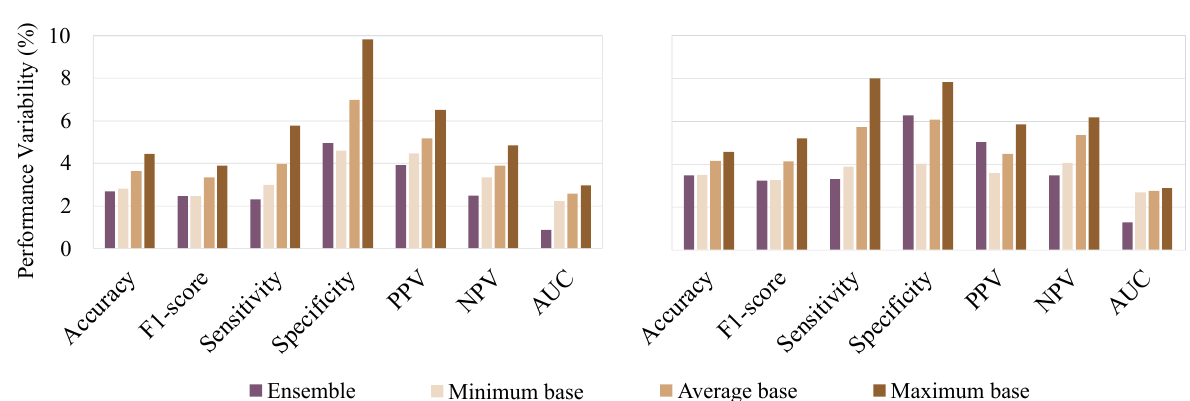
Figure 6. Base and ensemble classifiers performance variability for both validation ( left ) and testing ( right ) dataset. As for base classifiers, minimum, average and maximum variability were